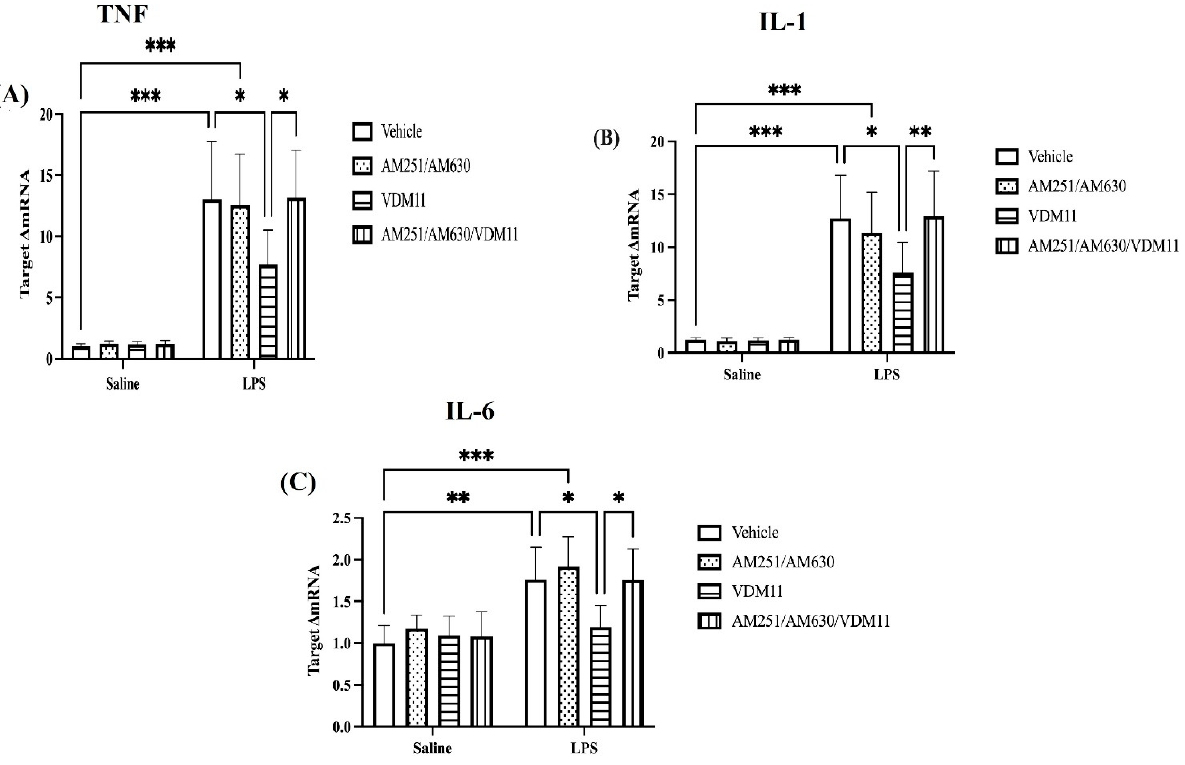
Figure 12. A combination treatment of 1 mg/kg each of AM251 and AM630 hindered the effects of 10 mg/kg of VDM11 on reducing the rise of TNF- α (A), IL1 β (B), and IL6 (C) caused by LPS injection in the hippocampus.* p < 0.05; ** p < 0.01; *** p <